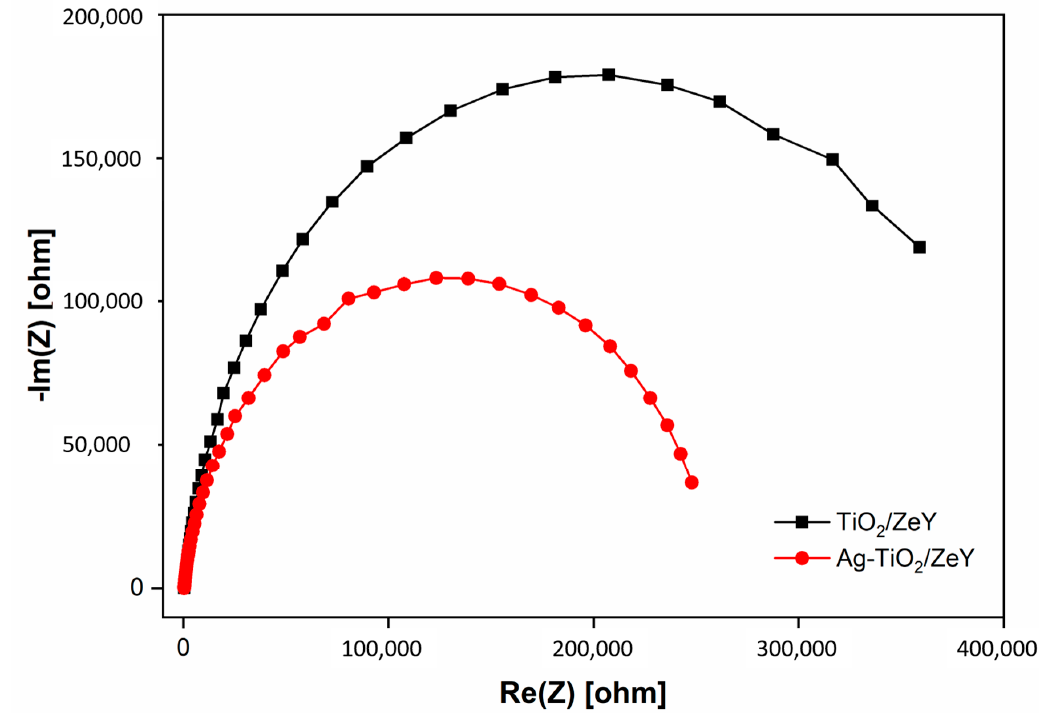
Figure 6. Electrochemical impedance spectra (EIS) of TiO 2 / ZeY and 1 wt. % Ag-TiO 2 / ZeY measured at − 0.20 V forward